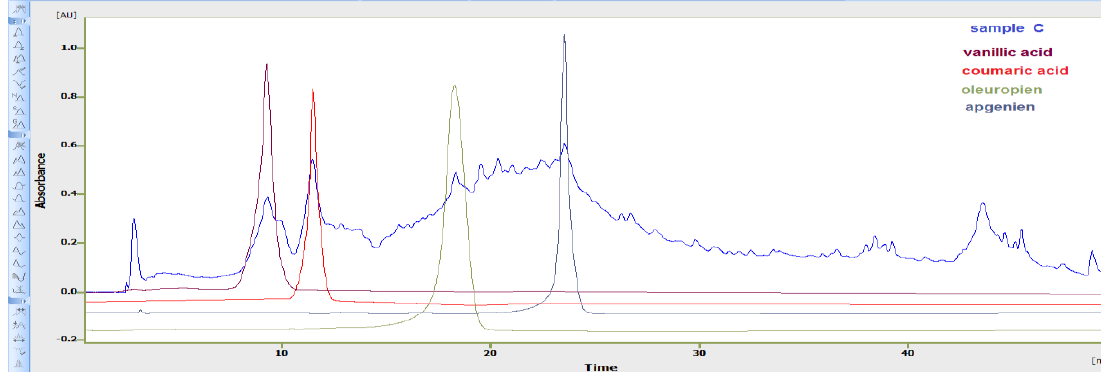
Figure 2. HPLC chromatogram for chloroform fraction.